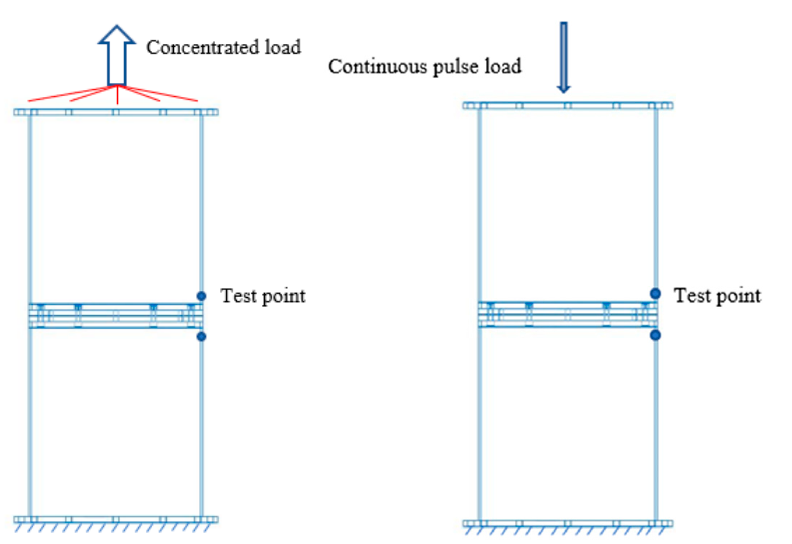
Figure 7. Load schematic.